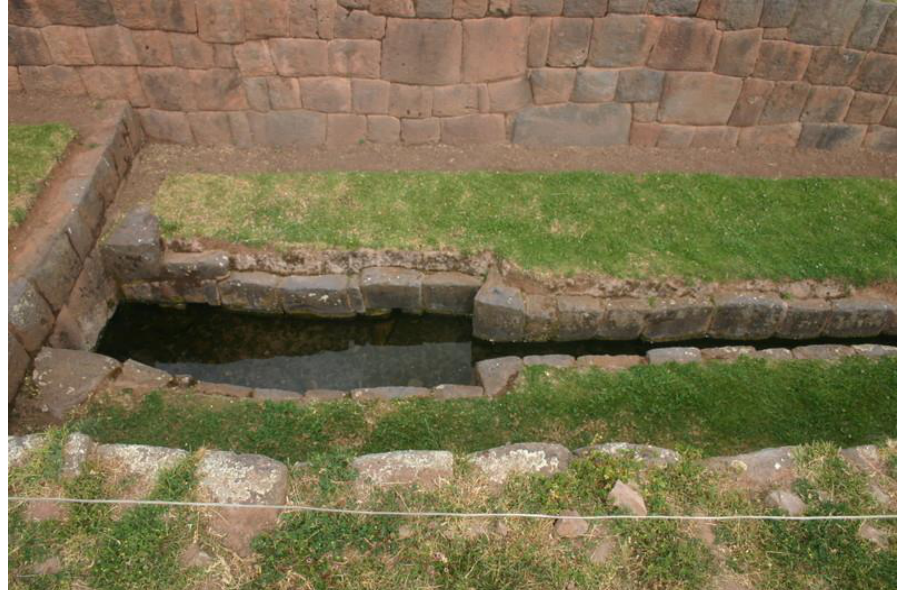
Figure 11. Channel cross-section geometry change made to induce critical flow in the contracted channel section to downstream channels supplying the Figure 9 Waterfall. This structure is associated with the upstream water supply to the Waterfall. (Photo by C. Ortloff)